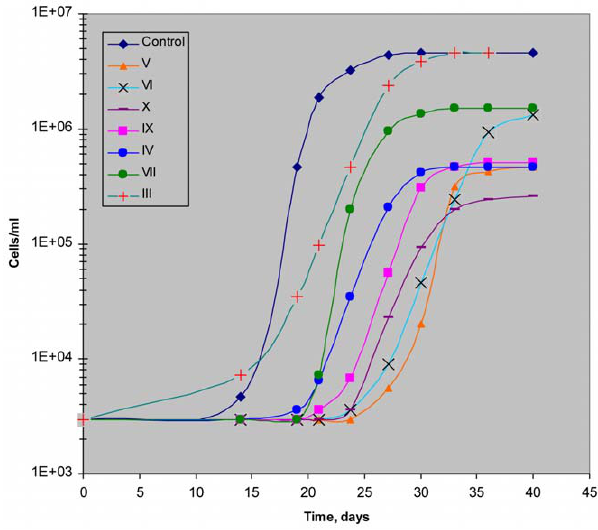
Figure 5. Influence of NPT compounds on resuscitation of M. tuberculosis ‘‘non-culturable’’ cells obtained in vitro . ‘‘Non- culturable’’ cells of M. tuberculosis cultures were obtained after cell cultivation during 50 days in Sauton’s medium without K + . Resuscitation was performed in the absence or presence of inhibitors at 10 m g/ml using 10-fold serial dilutions (MPN assay). MPN values were counted periodically during resuscitation time until their stabilization. replaced the dialkyldithiocarbamate group by a thiocyanate group which has similar electron affinity. Using a facile synthesis of the target we obtained several ortho nitroarylthiocyanate derivatives (Figure 1), based on the reaction of nucleophylic substitution, the active chloroatom in nitroaryl moiety was substituted by thiocyanate ion.